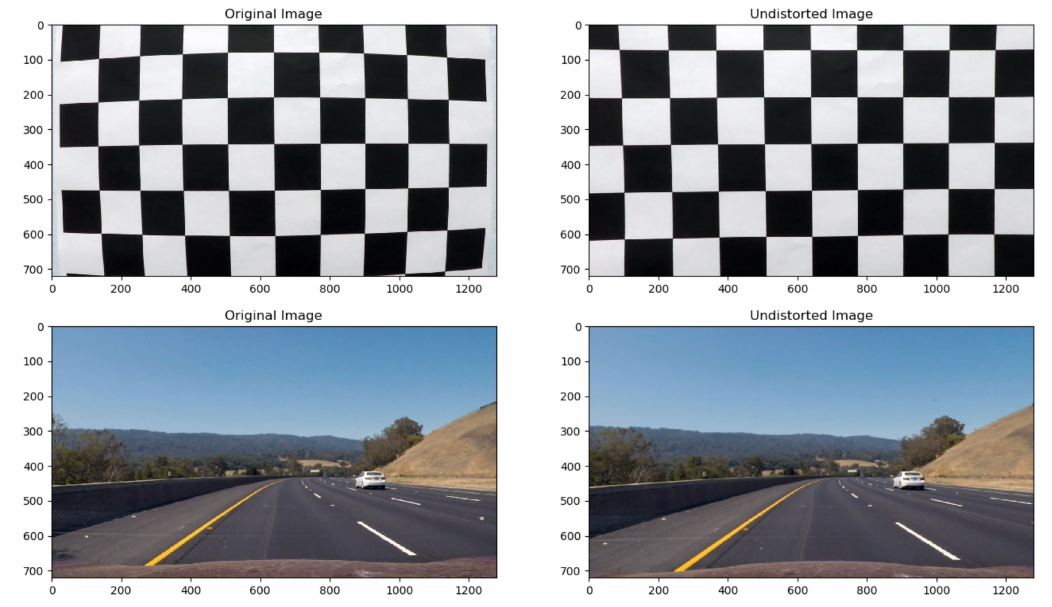
Figure 3. The correction of the distorted